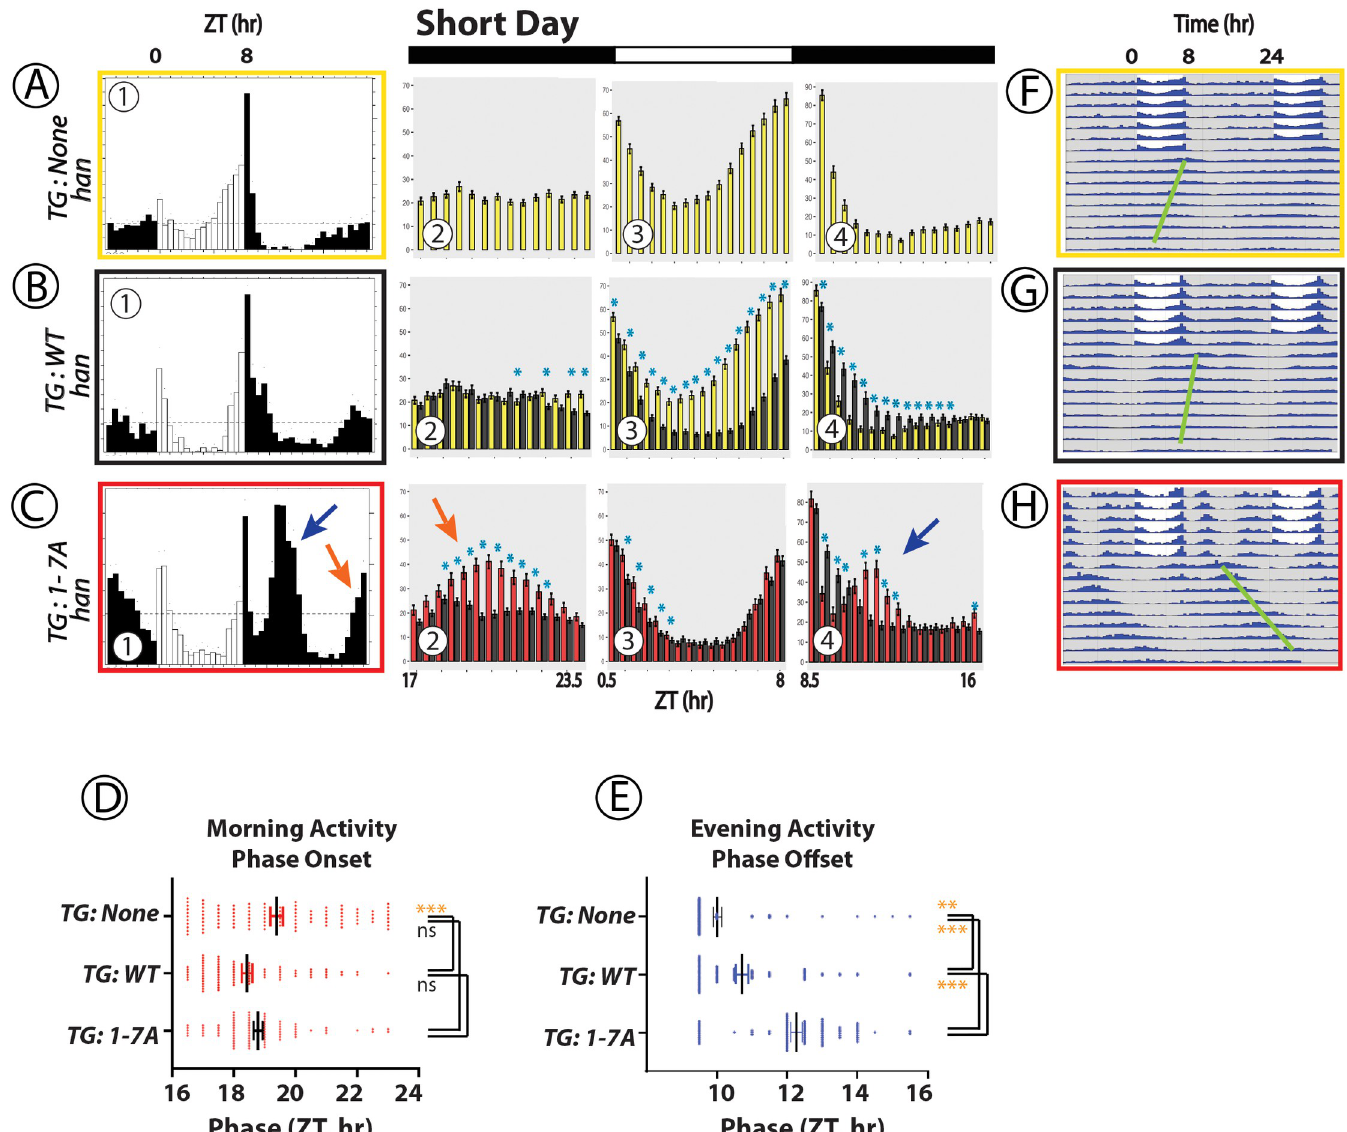
Fig 2. Locomotor Rhythms exhibited by pdfr mutant flies expressing the WT PDFR versus the 1-7A PDFR Variant under Winter-like (Short Day) conditions. All behavioral records were recorded from han ( pdfr mutant) flies that expressed either no UAS transgene (A, yellow box), or a UAS-WT pdfr transgene (B, black box) or a UAS-1-7A pdfr (C, red box)). Panels (A)-(C) contains sub-panels 1–4. Sub-Panel (1) displays group eductions (6-day activity averages) with open bars indicating the 8-hr periods of Lights-on and filled bars the 16-hr periods of Lights-off. TG : transgene. The red and blue arrows indicate Morning and Evening activity periods respectively in the 1-7A records that have distinguished amplitude or phase. Amplitude measures are displayed in Panels 2–4: 30 min bins for each genotype, color-coded and directly- compared (i.e., Panel C-2 through C-4 compares the amplitudes of the WT PDFR activity (black) with that of the 1-7A PDFR activity (red). The bins representing the light-dark transitions were removed. Blue asterisks mark amplitudes that are significantly different between genotypes by ANOVA followed by a Students t-test (p < 0.05). Panel (D) displays the average Phase Onset timepoint for the Morning activity for each genotype over the last two days of entrainment (LD 5–6). Panel (E) displays the average Phase Offset timepoint for the Evening activity for each genotype over the last two days of entrainment (LD 5–6). Analyses in (D) and (E) represent ANOVA followed by Dunnett’s post hoc multiple comparisons of all compared to WT: ns = not significant; � = p < 0.05; �� = p < 0.01; ��� = p < 0.005; ���� = p < 0.001. Panels (F)–(H) present double plotted actograms of group activity for each genotype (color-coded) over the ~6 days of light entrainment, followed by ~9 days of constant darkness (DD). The green bars indicate the phases of the dominant activity periods in